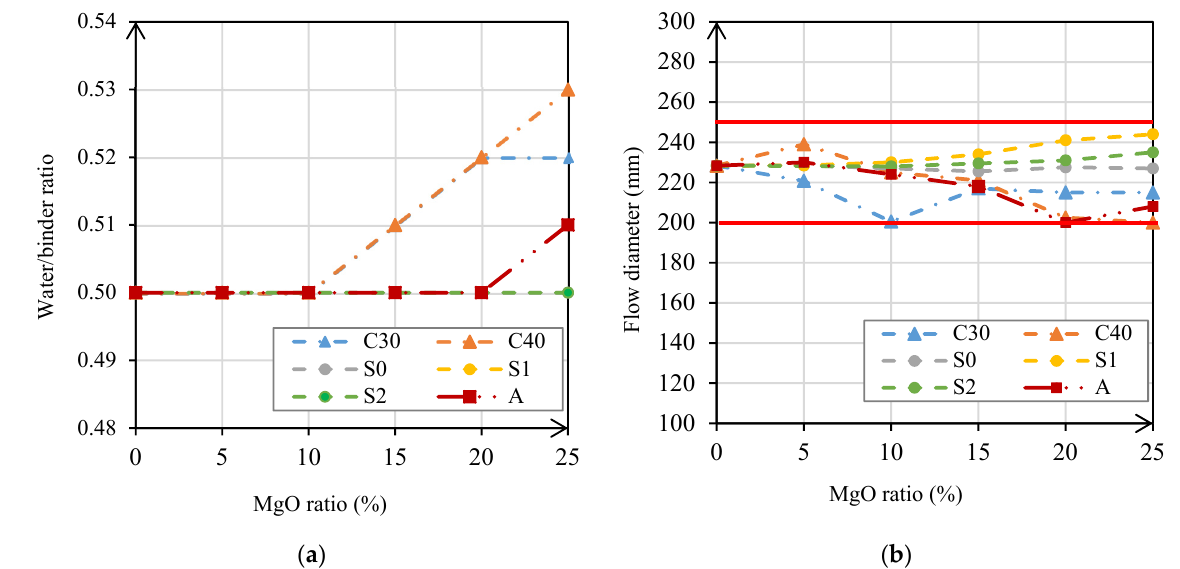
Figure 2. W/b ratio of each mix ( a ); mortar consistency according to the MgO content ( b ).